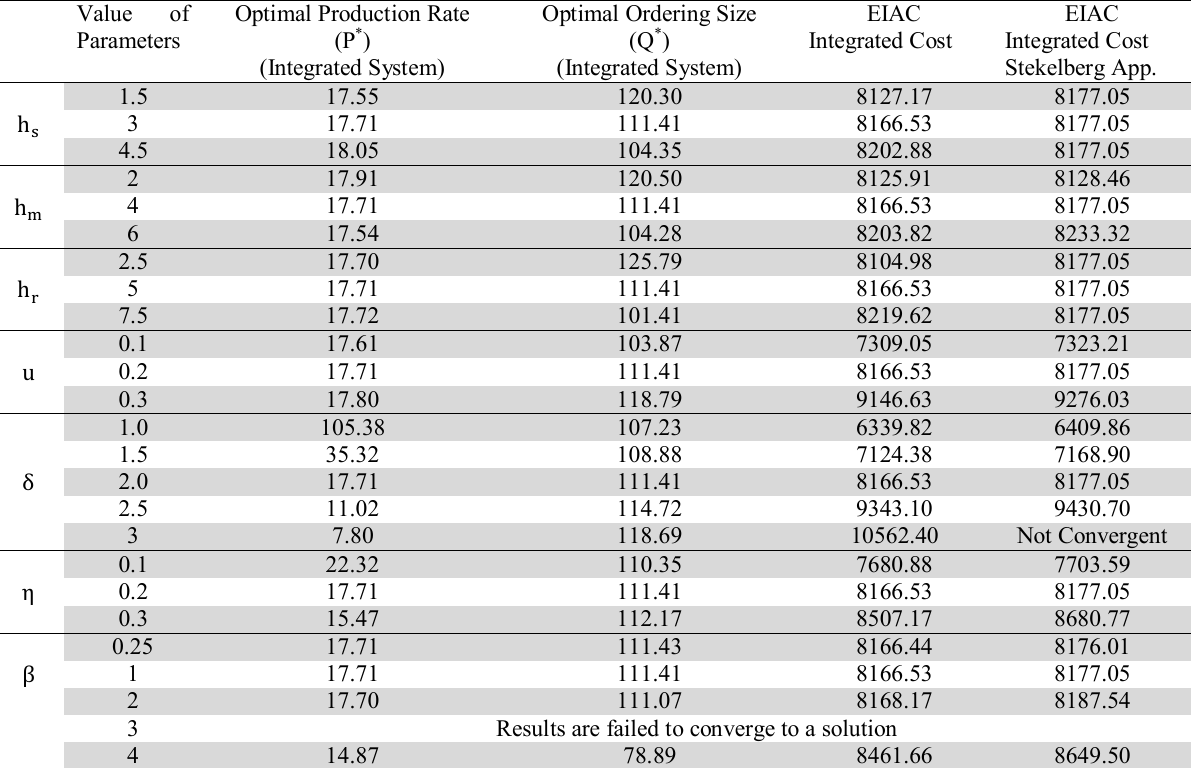
The results of sensitivity